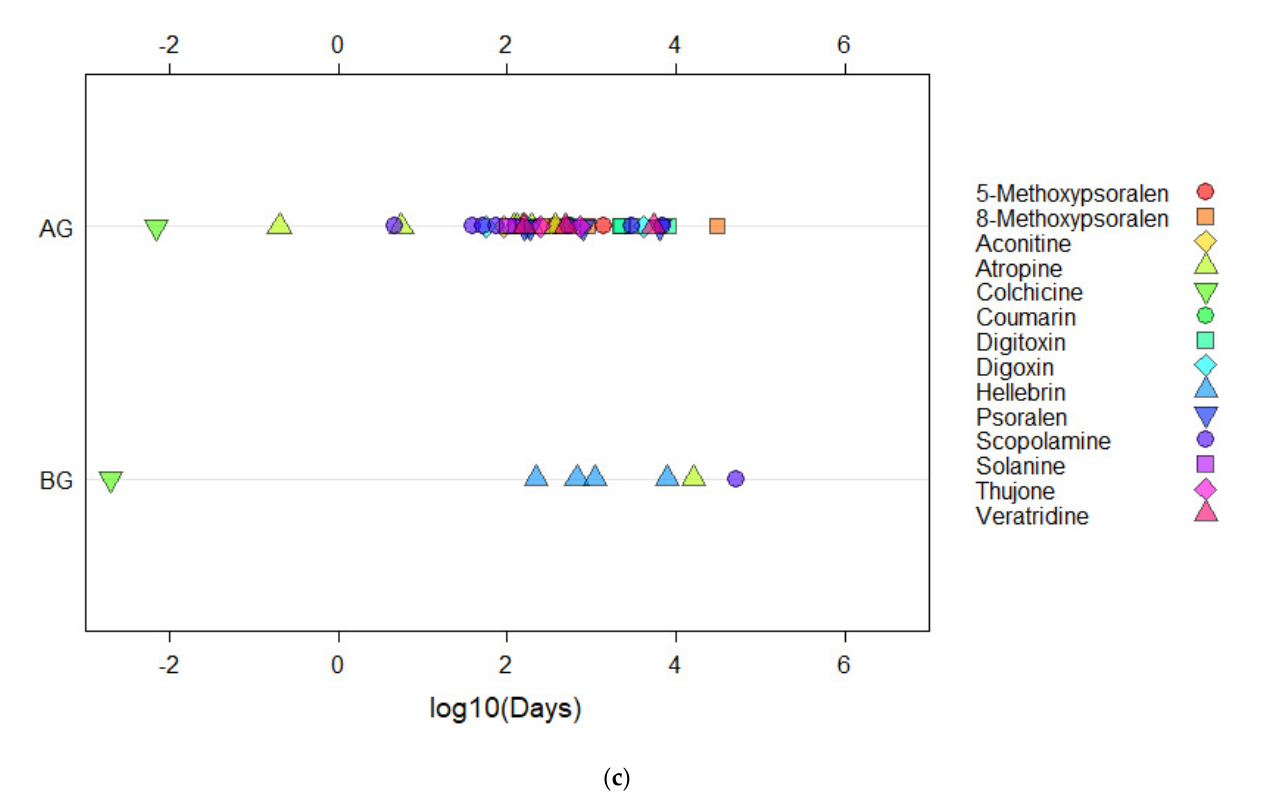
Figure 2. Dot plots investigating the human health risk based on the number of days exposure to reach the compound LD50, as expressed as toxicity ( a ) Influence of plant anatomy, ( b ) Effect of plant family, and ( c ) Positioning of plant anatomy (above or below ground).